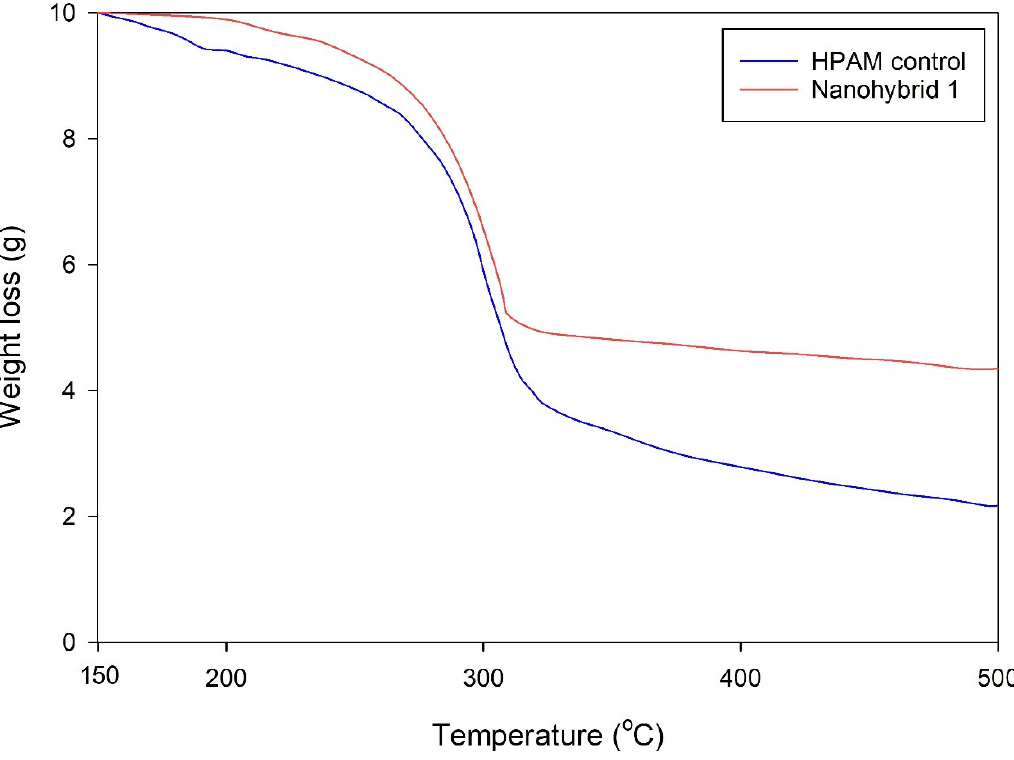
Figure 3. TGA (thermogravimetric analysis) profile of dried samples of HPAM (Partially hydrolyzed polyacrylamide) solution and nanohybrid 1.